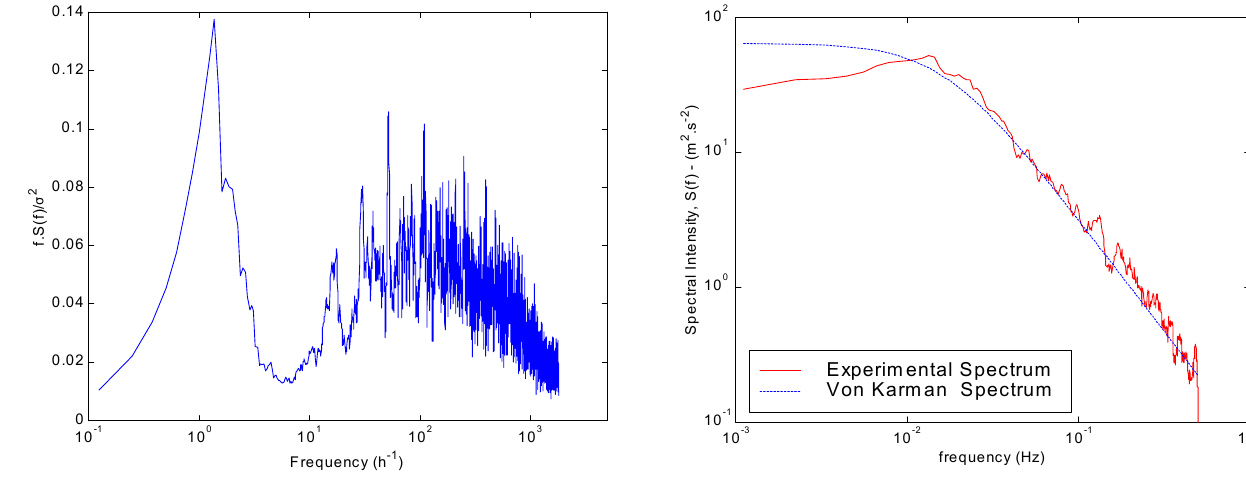
Figure 8 : Fig. 8. Wind spectrum for the period 00:00–08:00LT (Plot CT, 25 July 1997). One can see the spectral gap separating the mean and the turbulent flows.